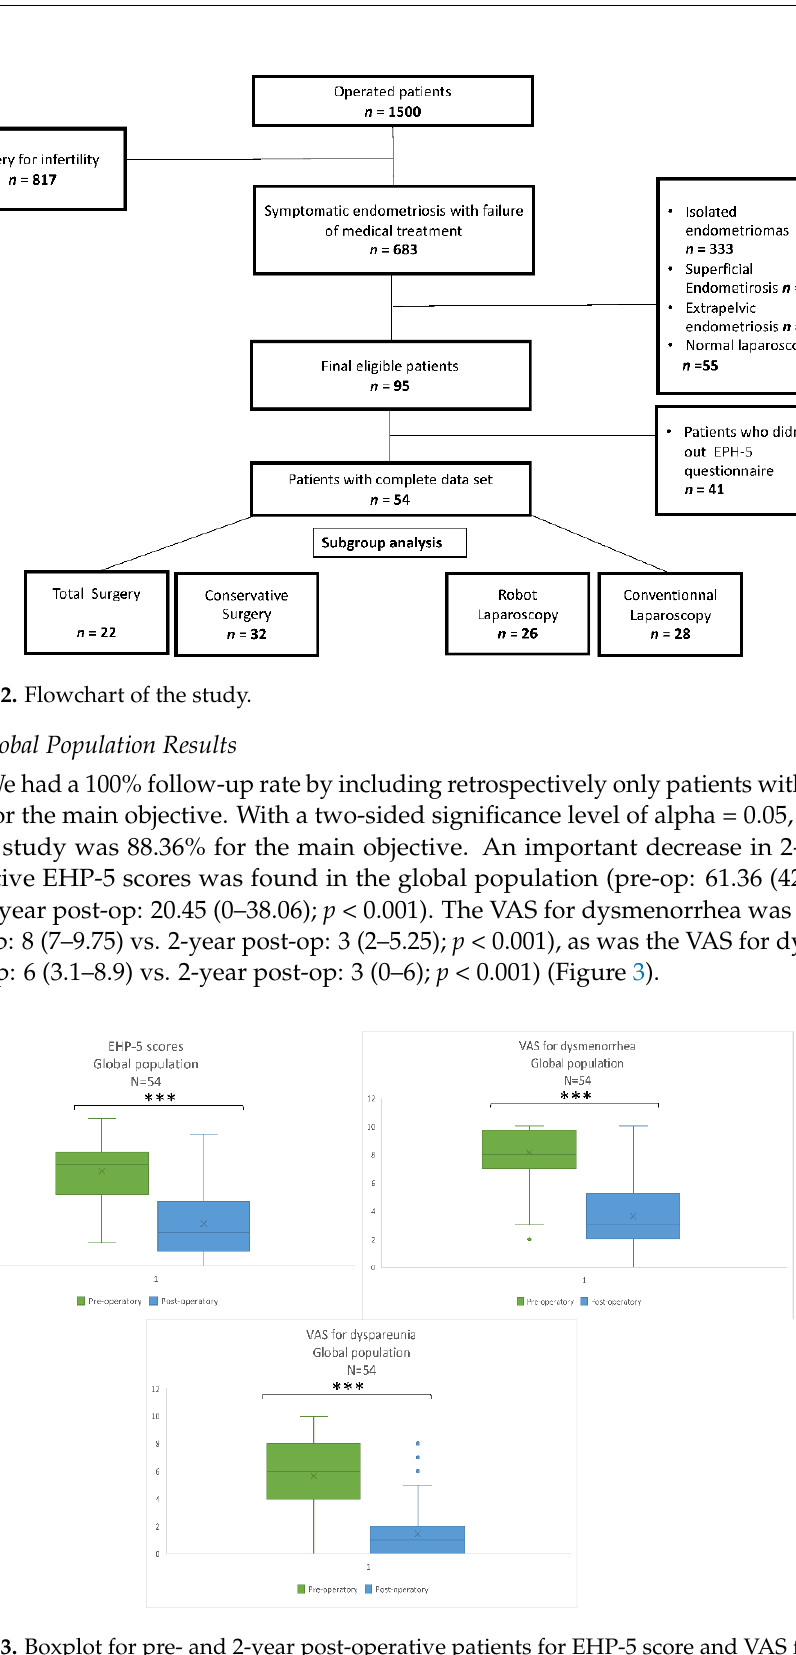
Figure 3. Boxplot for pre- and 2-year post-operative patients for EHP-5 score and VAS for dysmen- orrhea and dyspareunia in the global population. Each boxplot shows the median and 1st and 3rd quartiles, and minimal and maximal values. represents missing data. *** p < 0 .001.